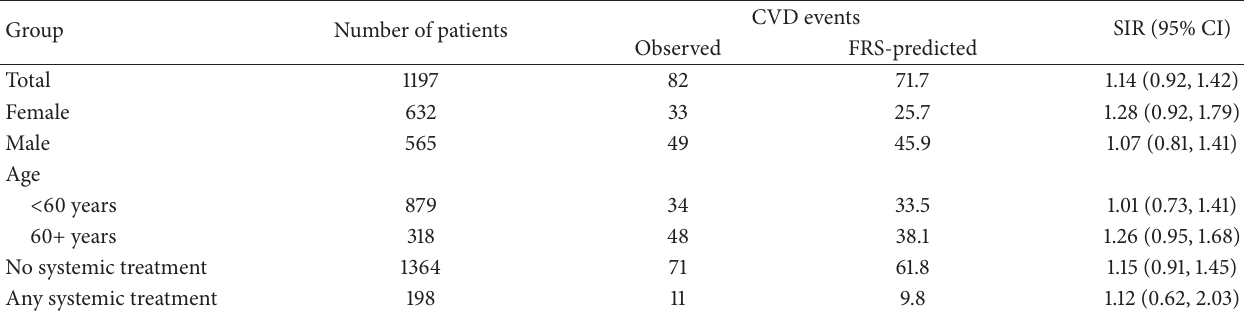
Table 2: Comparison of observed and FRS-predicted CVD risk in patients with